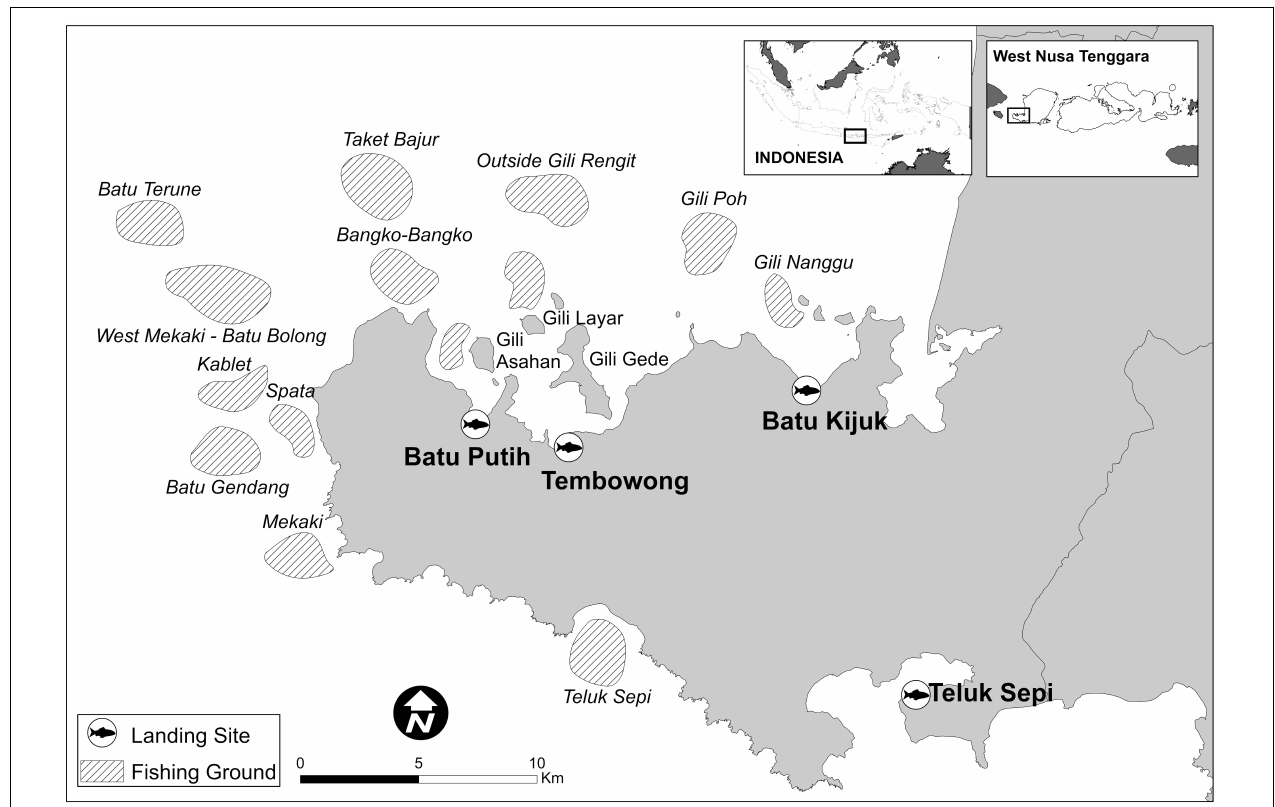
FIGURE 1 | Fishing ground locations and landing sites where data was collected in the Sekotong region of Lombok,